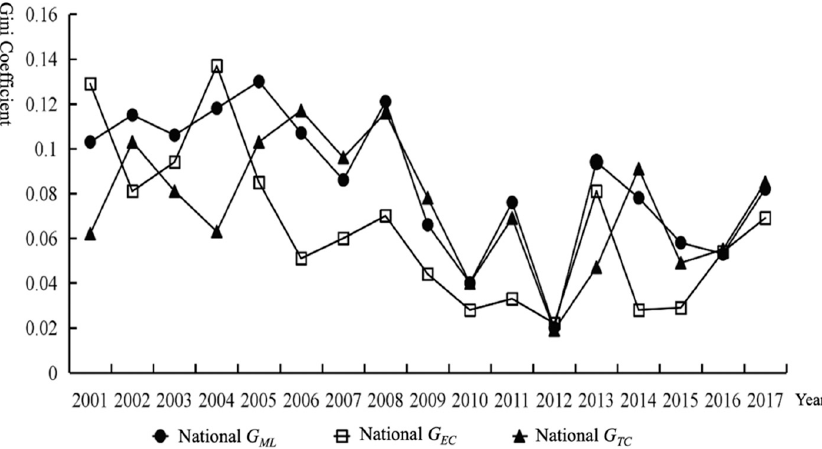
Figure 4. The Total Gini Coefficient of ML , EC , and TC .